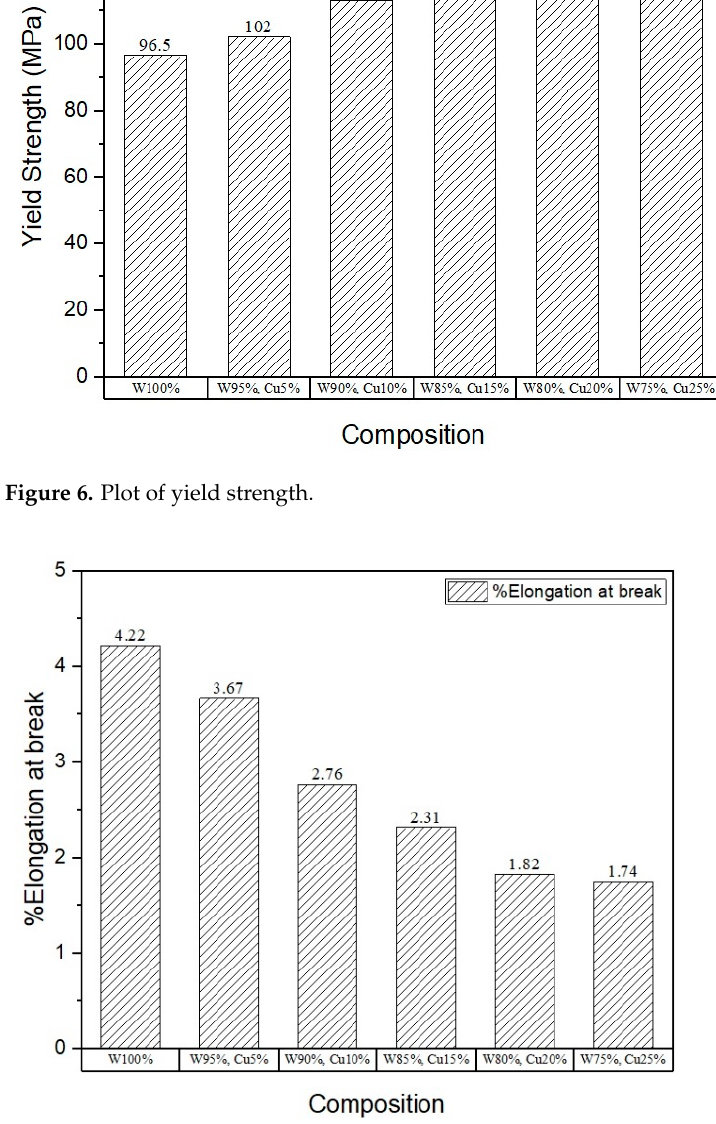
Figure 7. Plot of %elongation. Figure 7. Plot of